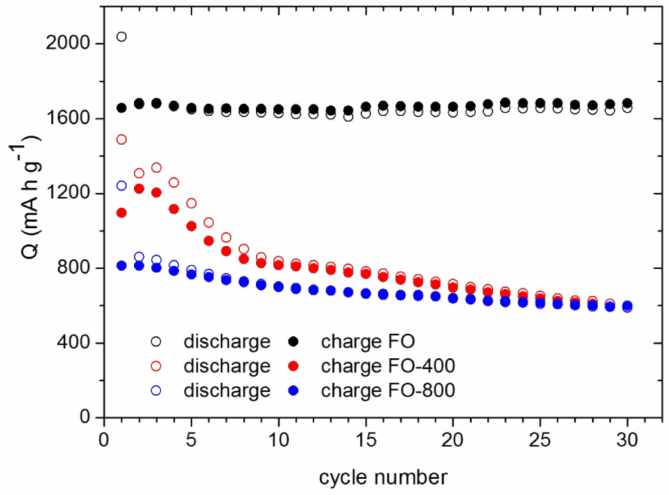
Figure 5. Specific capacity vs cycle number at 1 A g − 1 for the FO